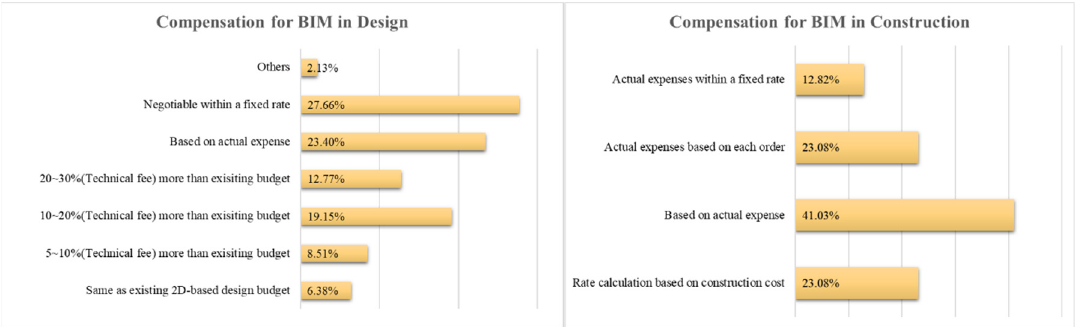
Figure 7. Preferences on BIM Compensation.